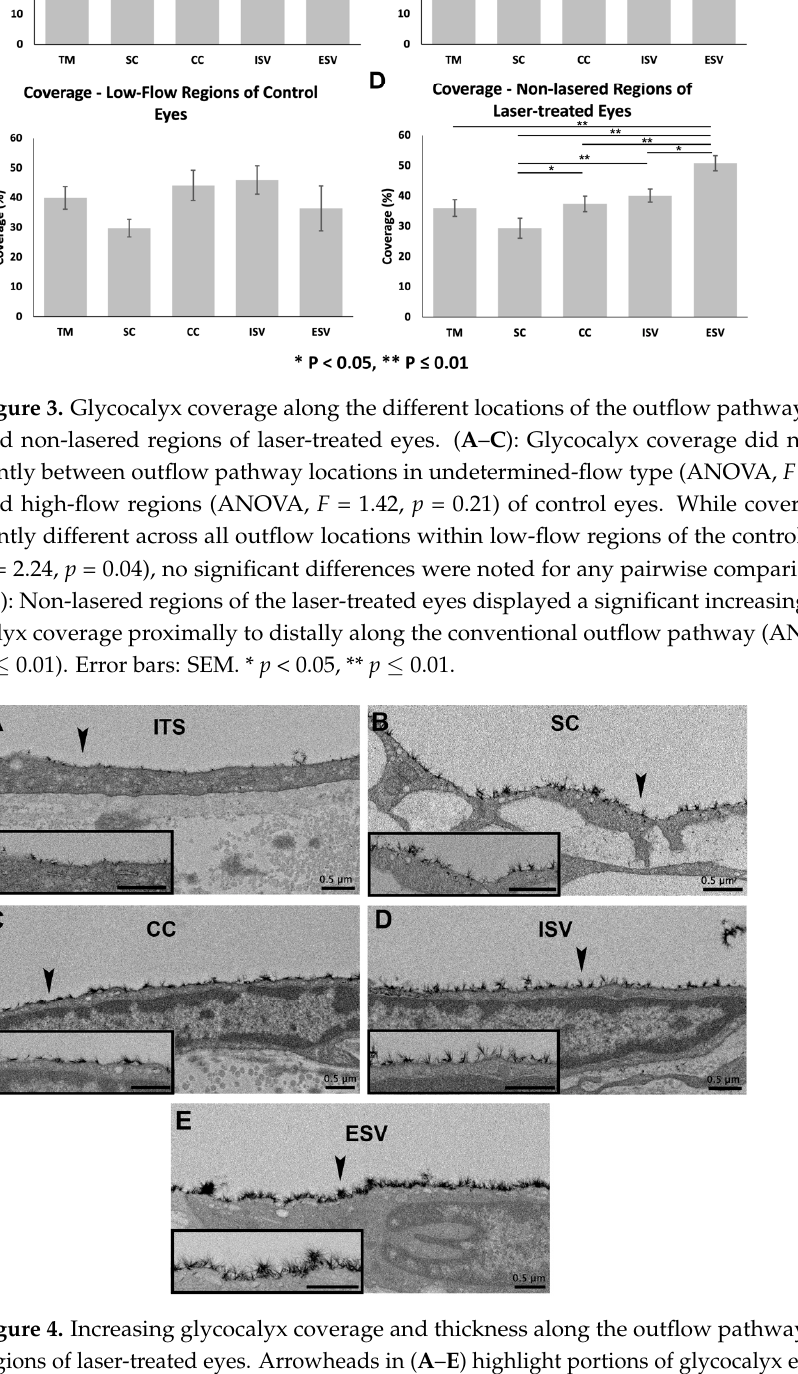
Figure 4. Increasing glycocalyx coverage and thickness along the outflow pathway in non-lasered regions of laser-treated eyes. Arrowheads in ( A – E ) highlight portions of glycocalyx evaluated at high magnification in the inset images of each respective panel. In evaluating non-lasered regions in the ( A ) trabecular meshwork (TM), ( B ) Schlemm’s canal (SC), ( C ) collector channels (CCs), ( D ) intrascleral veins (ISVs), and ( E ) episcleral veins (ESVs), both glycocalyx coverage and thickness displayed a general increasing trend proximally to distally along the outflow pathway. ITS: inter- trabecular space.